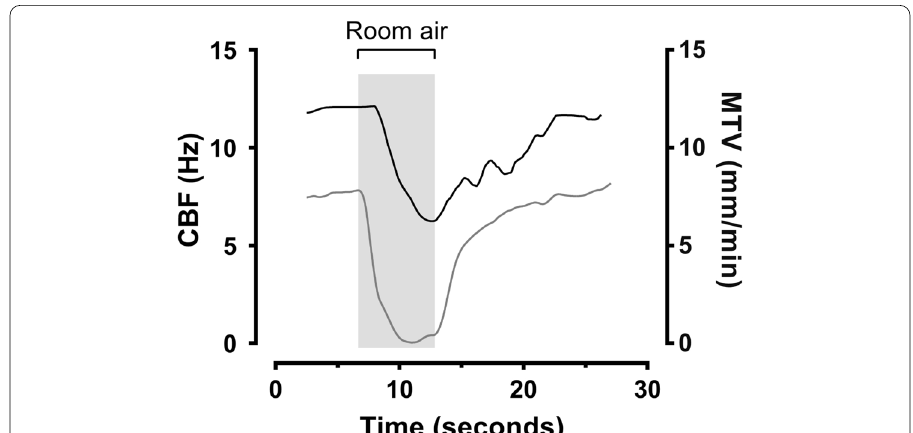
Fig. 3 An example of the effect of intermittent exposure of room air on the cilia beat frequency (CBF) and mucus transport velocity (MTV) from a video-microscopy recording shown in Additional file 1: Video S1. The gray region represents room air and white regions represent air at body temperature and fully saturated with water vapor